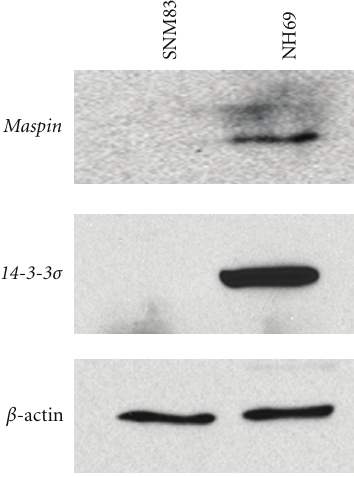
Figure 3: Chondrosarcoma cells expression of maspin and 14-3-3 σ proteins. Western blot analysis for maspin and 14-3-3 σ . Lane 1 is the SNM83 chondrocyte cell line which shows no protein expression for either maspin or 14-3-3 σ , and in lane 2 the NH69 chondrosarcoma cell line shows a robust induction of both proteins. These are consistent with real-time PCR results of mRNA expression. Beta- actin was used as the loading control.